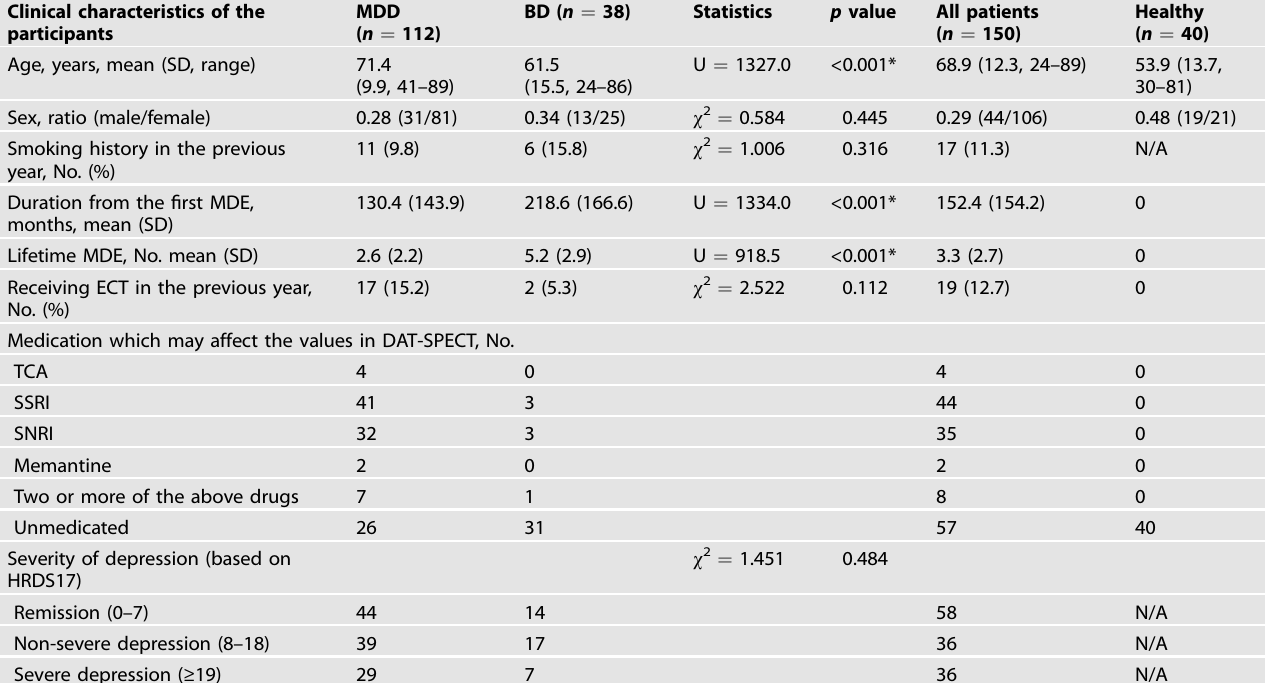
Table 1. Clinical characteristics of the